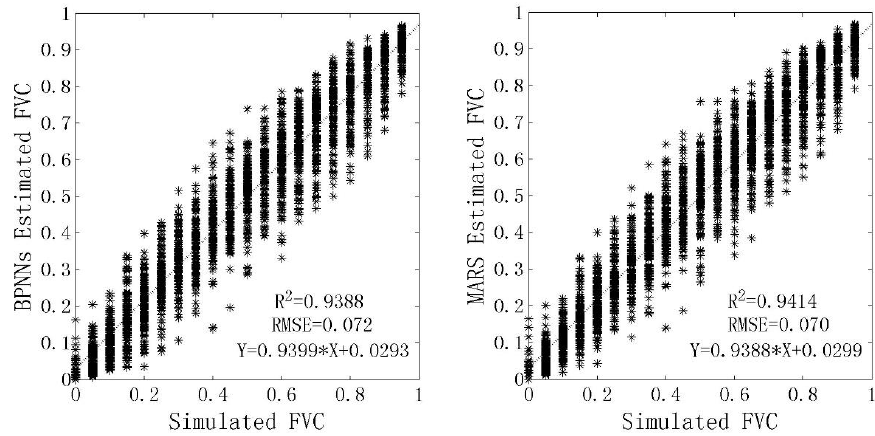
Figure 5. Theoretical performances of: back-propagation neural networks (BPNNs) ( left ); and multivariate adaptive regression splines (MARS) ( right ) using Landsat 7 ETM+ simulated data.